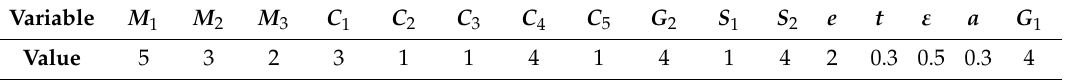
Table 5. Initial simulation parameters.